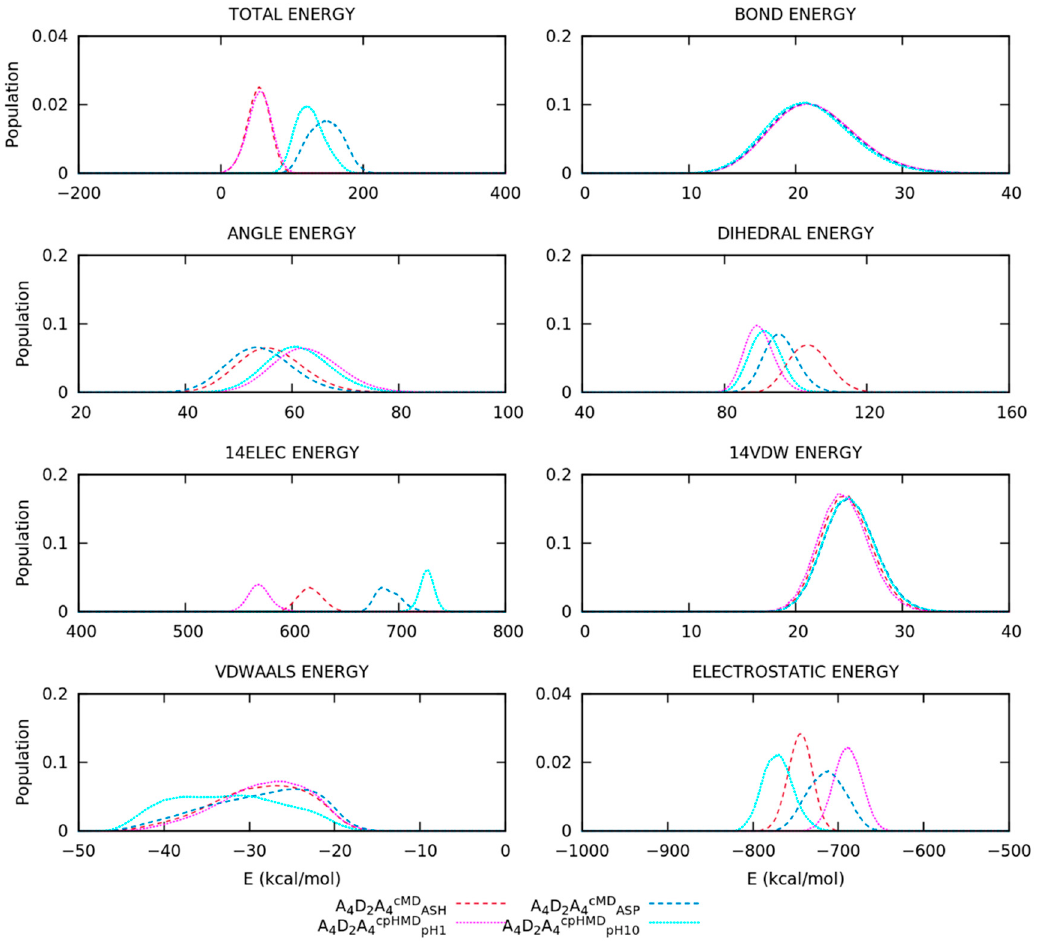
Figure 9. Normalized distributions of total, intra-, and intermolecular energies of the oligopeptides. The first set of plots in the ( top ) corresponds to the DA 8 D peptide and the second set in the ( bottom ) corresponds to the A 4 D 2 A 4 peptide. The simulation methods are represented in dashed (cMD) or dotted (cpHMD) lines. Water molecules were not included in the calculations.